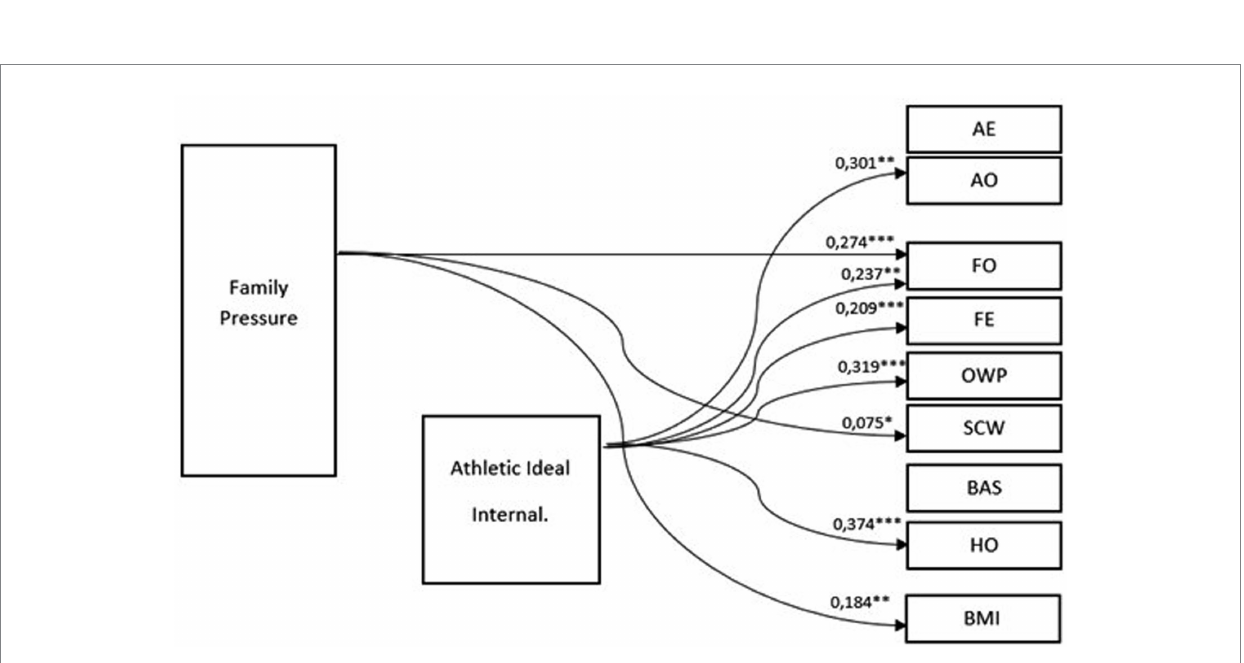
FIGURE 4 Path model (SEM) for young Italian women. N = 106; Chi 2 = 0.030; df = 1; p > 0.05; RMSEA = 0.036; CFI = 0.994. * = p < 0.05; ** = p < 0.01; *** = p < 0.001 (two tailed test).